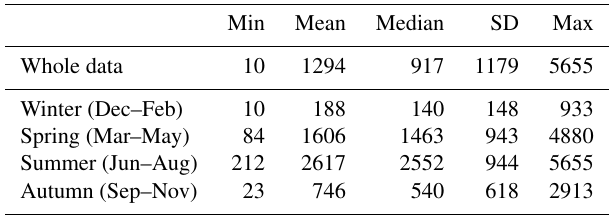
Table 1. Daily H er (Jm − 2 ) averaged over the whole period and for each season in Chilton during